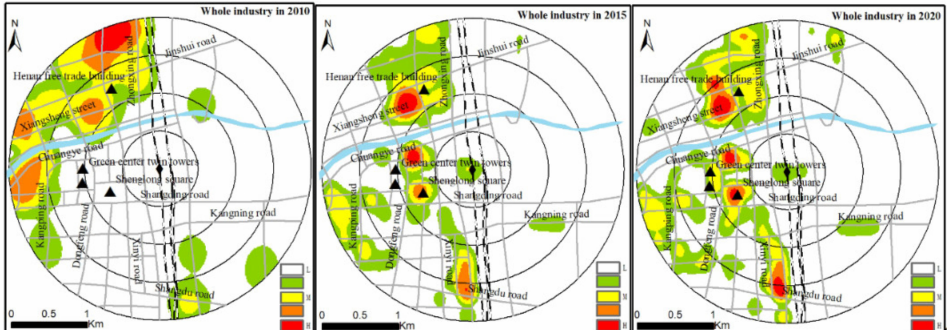
Figure 2. Kernel density analysis of the whole